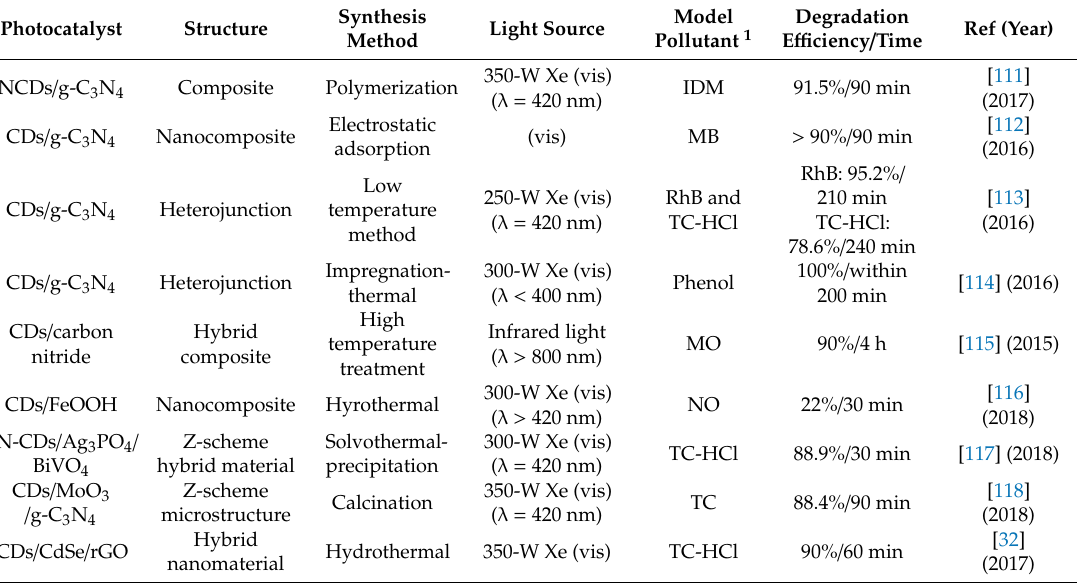
Figure 7. A schematic mechanism of Z-schemed NCDs / Ag 3 PO 4 / BiVO 4 photocatalyst to degrade organics. Figure adapted from reference [117]. Table 8. Photodegradation activity of miscellaneous other kinds of CD